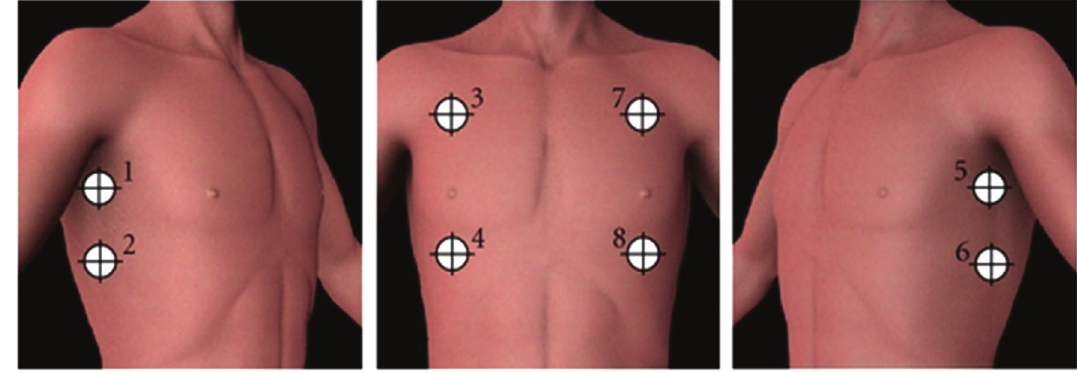
Figure 2: PneumoScan data acquisition points.